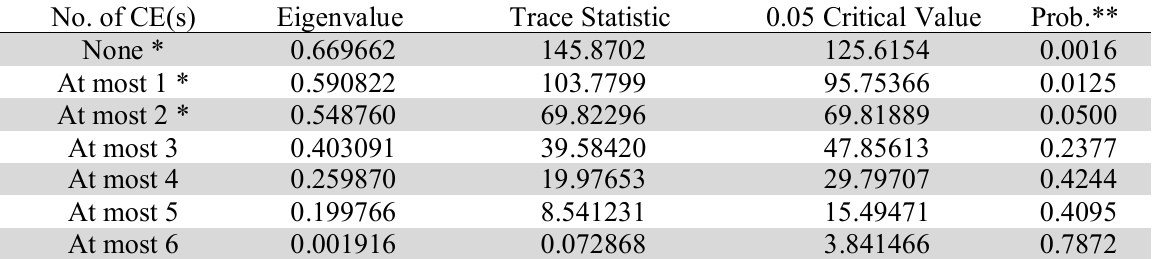
The results of unrestricted cointegration Rank